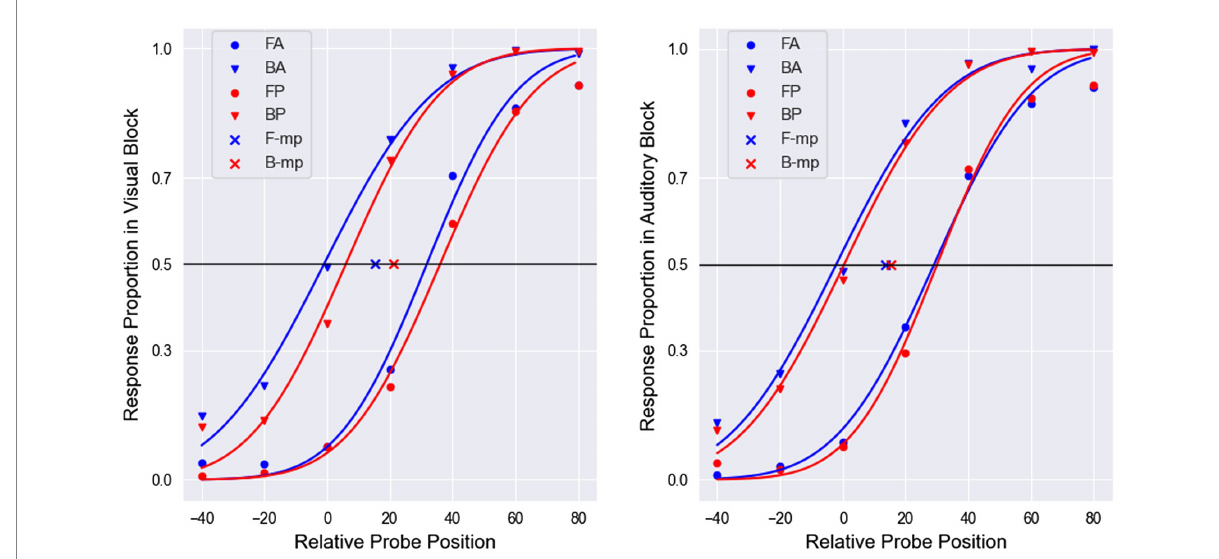
FIGURE 4 The proportion of responses at each probe position and their fitting curve in both the visual (left) and auditory (right) blocks. FA represents the forward proportion in the cue-absent condition. BA represents the 1-backward proportion in the cue-absent condition. FP represents the forward proportion in the cue-present condition. BP represents the 1-backward proportion in the cue-present condition. F-mp represents the midpoint between 0.5-height points on two red lines, and B-mp represents the midpoint between 0.5-height points on two blue lines. Taking “cue absent” as an example, the final PSE equals the abscissa of the blue “ x .” It can be seen that in the visual block, the red “ x ” is shifted to the right compared with the blue “ x ,” which means the observers were less likely to perceive the probe in front of the target when the cue was presented, and overall, the red lines were steeper than the blue lines. These results indicated that the visual cue increased FD and decreased SD, which suggested that phasic alertness boosts representational momentum and increased